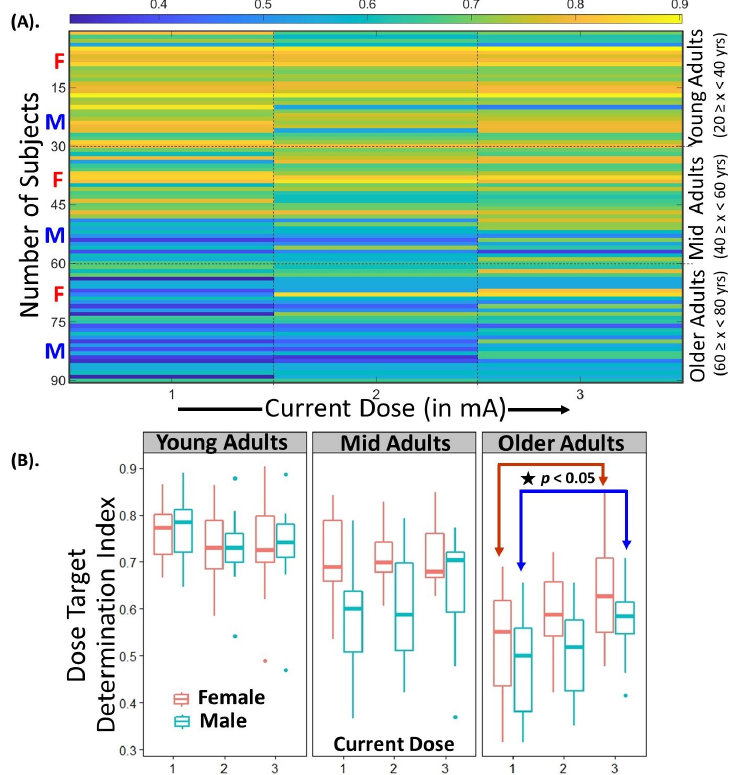
Figure 3. Illustration of the variation in DTDI at individual and group level with: ( A ) The individual variation of DTDI values (0 to 1) in the females (font in red ‘F’) and males (font in blue ‘M’) distributed equally across the three age groups ((i) young adults (20 ≤ x ˂ 40 years), (ii) mid adults (40 ≤ x ˂ 60 years), and (iii) older adults (60 ≤ x ˂ 80 years)) for the three current doses (1 mA, 2 mA, and 3 mA). The interindividual and intraindividual variation in DTDI clearly shows the cur-